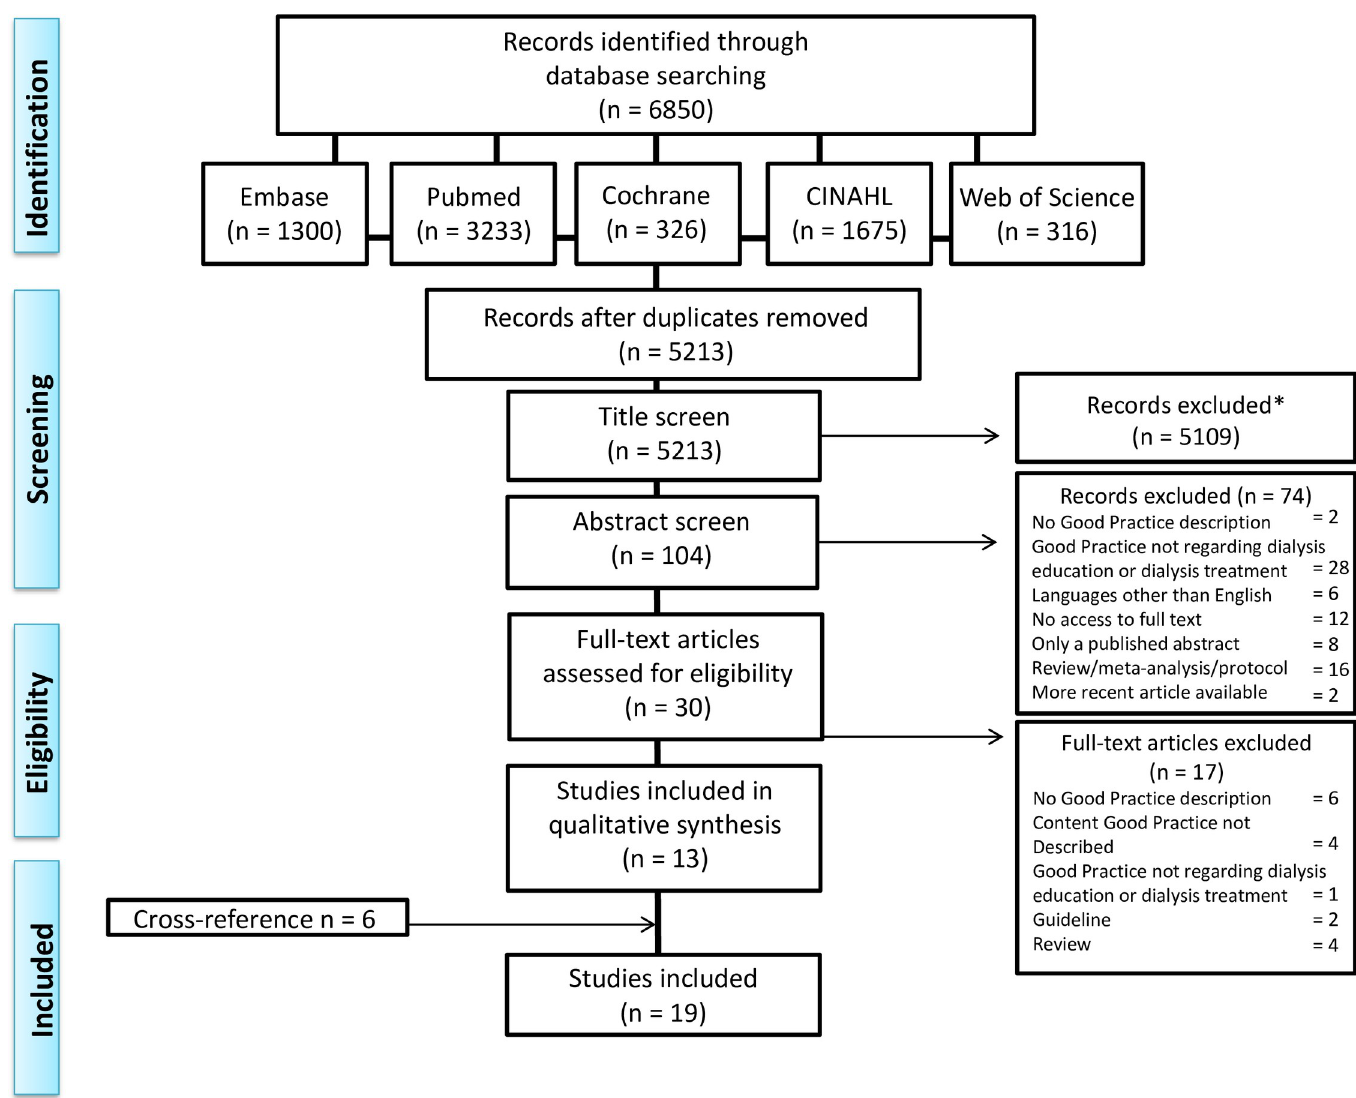
Fig 1. Selection flow diagram. � Exclusion criteria for title screen: No good practice regarding dialysis modality education/treatment or eHealth, implementation project, diabetes mellitus care or exercise program for dialysis patients, guideline, meta-analysis, protocol, review, and language other than English.